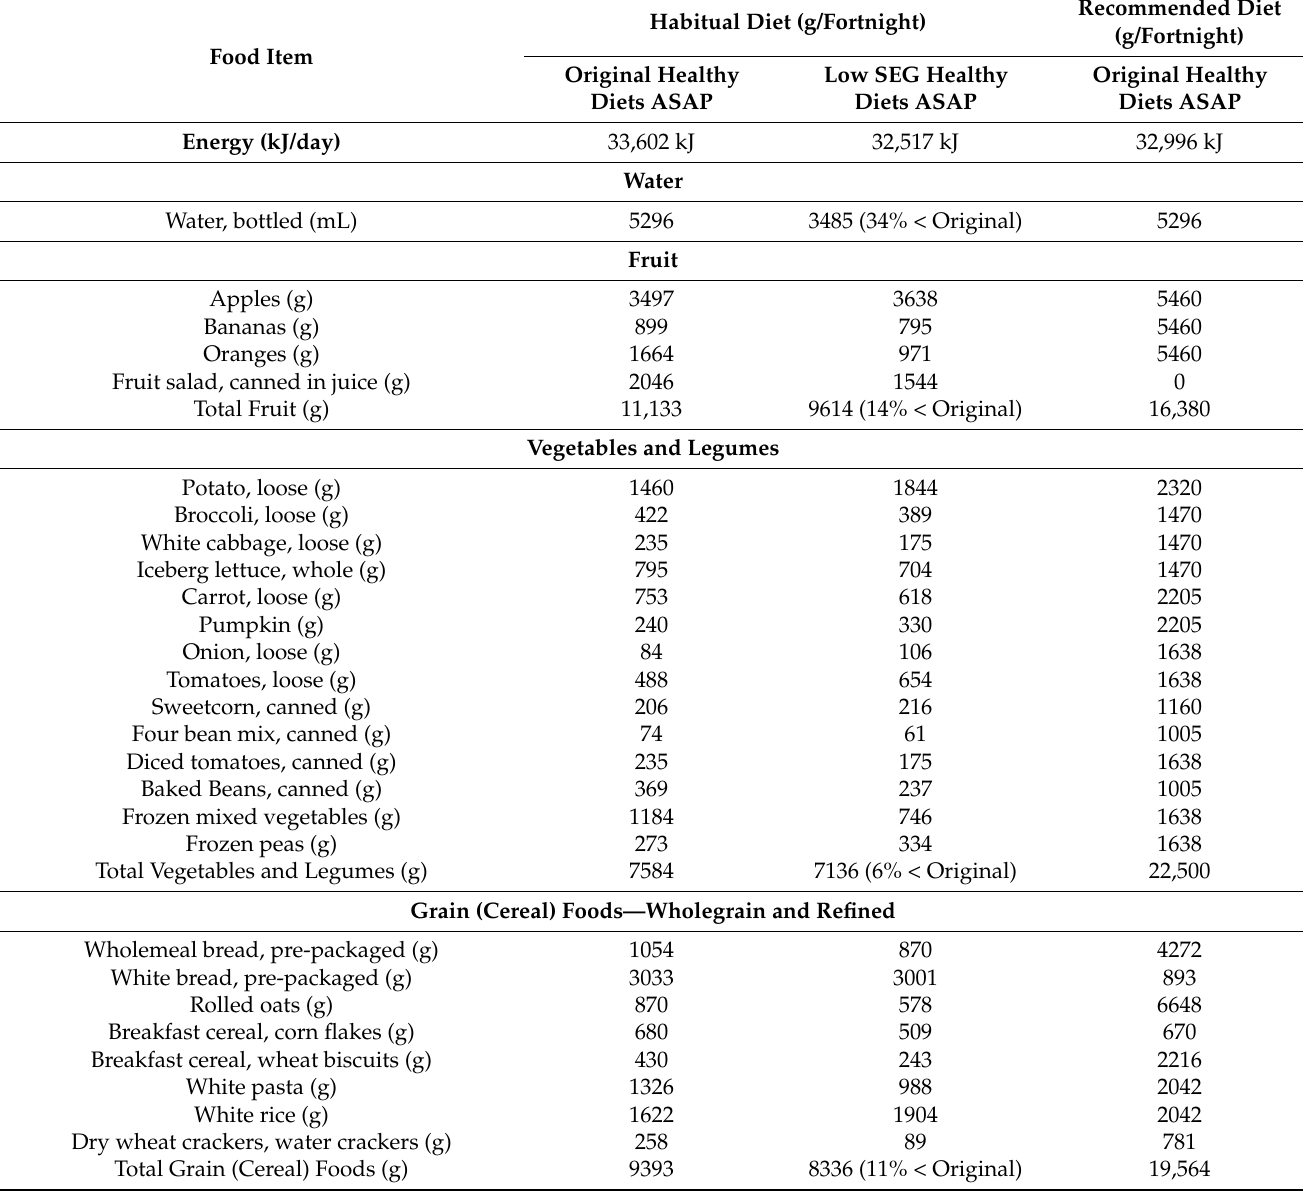
Table 2. Composition of original Healthy Diets ASAP habitual diet pricing tool for mean Australian population and Low SEG Healthy Diets ASAP habitual diet pricing tool, and recommended diet pricing tool, for Household A (two adult, two